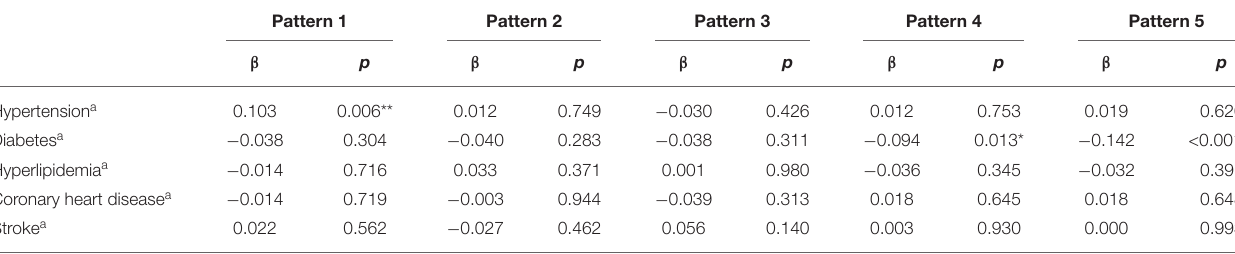
TABLE 6 | Association between dietary patterns and chronic